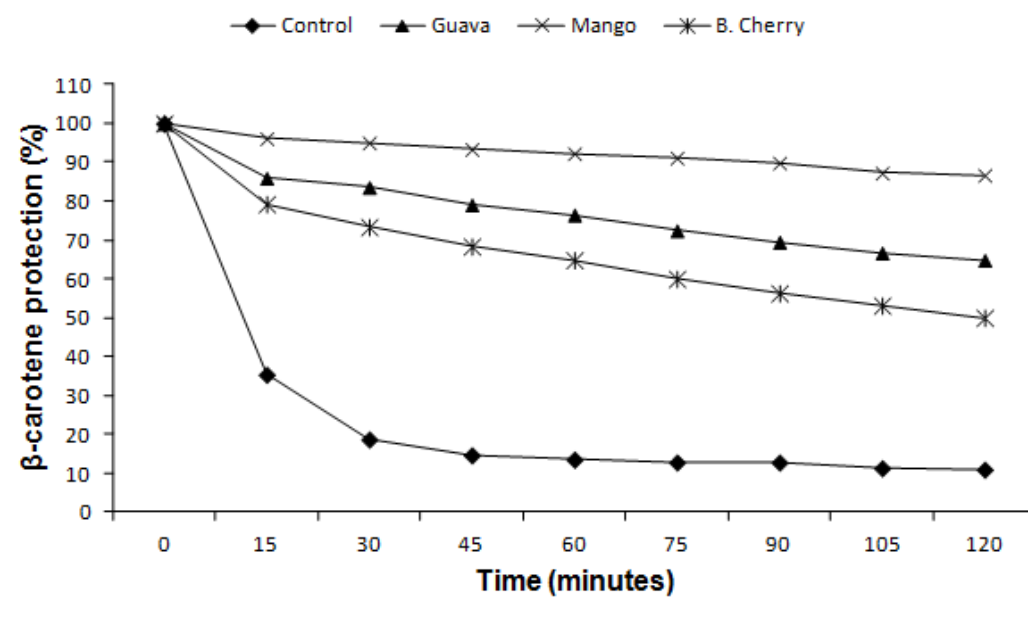
Figure 2. Protection of β -carotene oxidation added of extracts of fruits